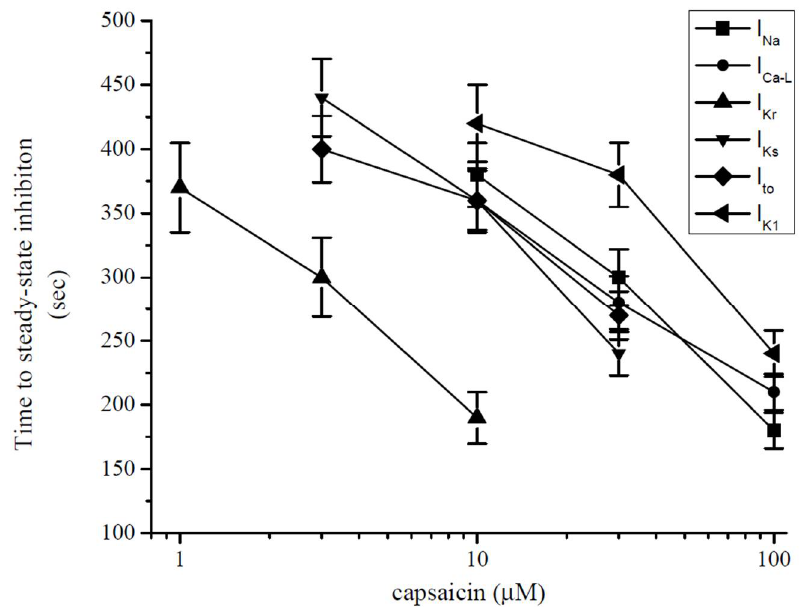
Figure 8. Relationship between time to reach steady-state maximal inhibition and capsaicin concen- tration for I Na , I L-Ca , I Kr , I Ks , I to , and I K1 (each data point indicates mean ± SEM from 5–7 cells). Steady-state level was determined when three consecutive data points had the same (within the 97%)